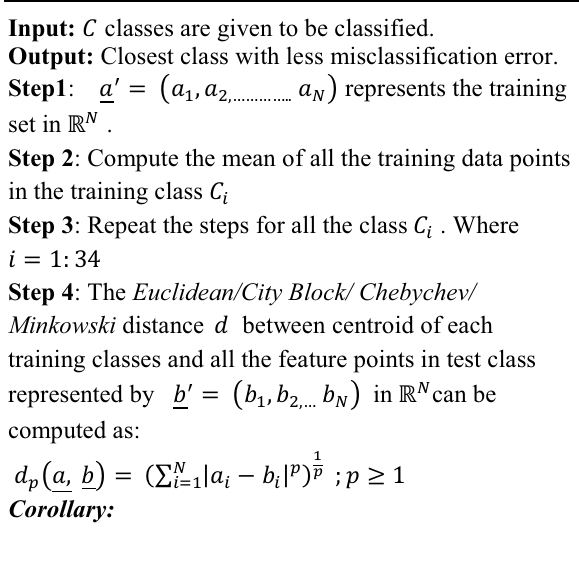
probability. In our case C = 34